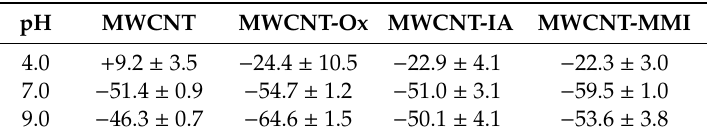
Table 1. Zeta potential values of all MWCNTs after the third ultrasonication cycle (Ox = oxidized, IA = itaconic acid, MMI =